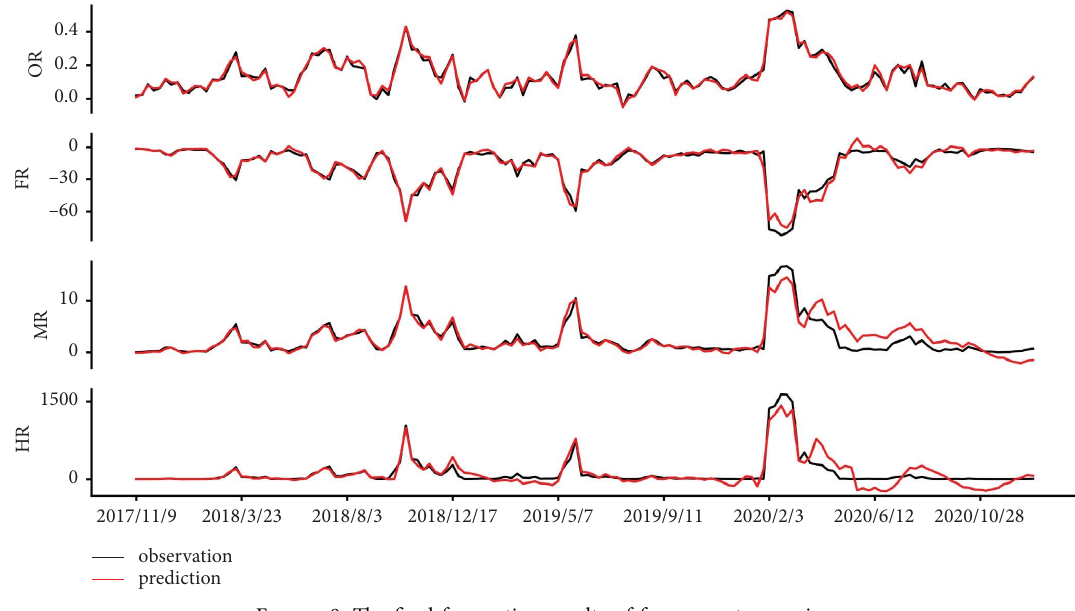
Figure 8: Te fnal forecasting results of four curvature series. Table 4: Te evaluation metrics of the WD-LSTM model.